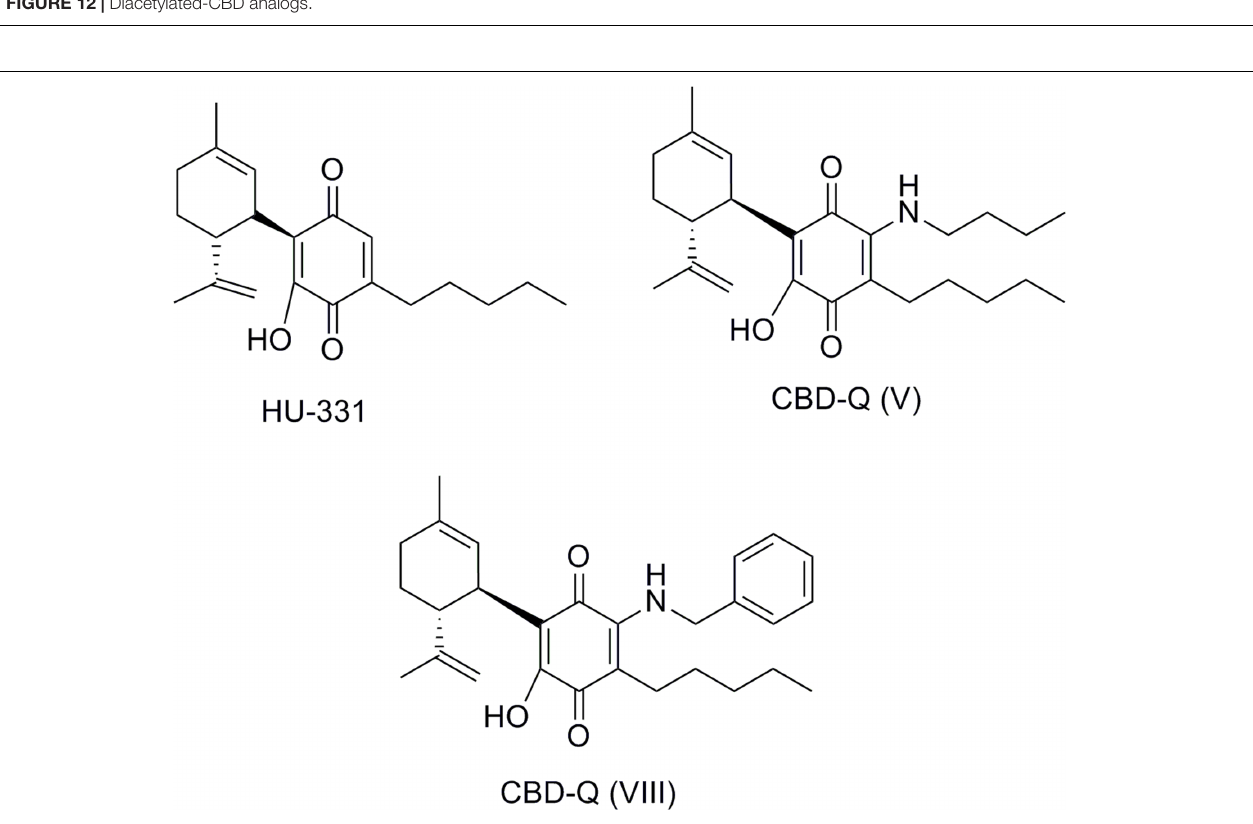
FIGURE 12 | Diacetylated-CBD analogs.